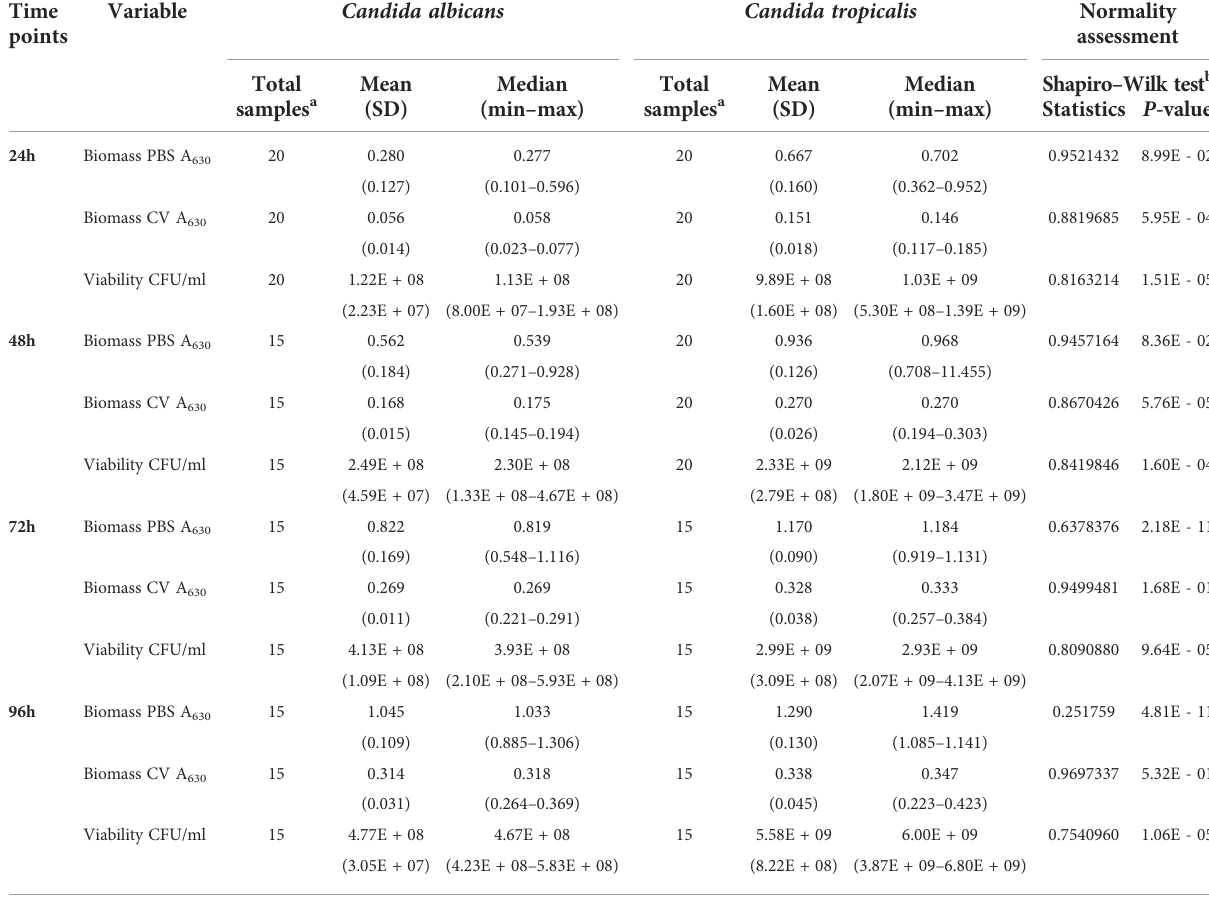
TABLE 1 Summary of the results and statistical analysis obtained from the biomass and viability assays of growth with Candida albicans and Candida tropicalis